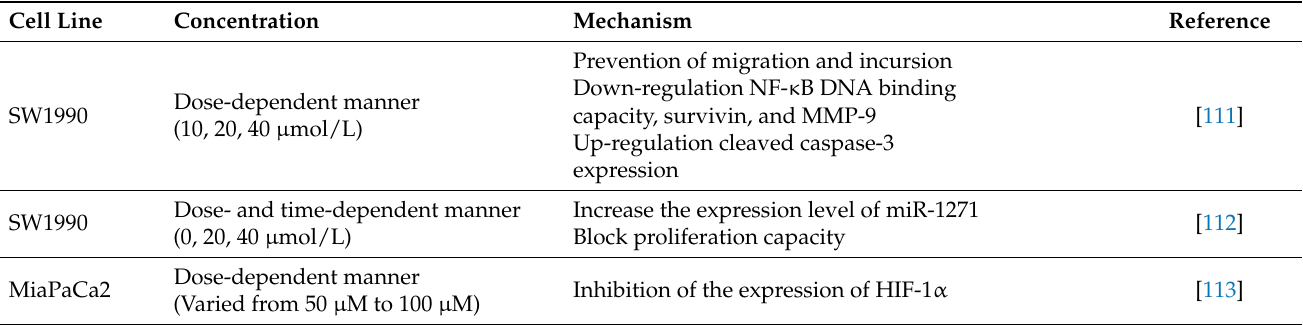
Table 4. Summary of in vitro biochemical effects of emodin in pancreatic cancer cell